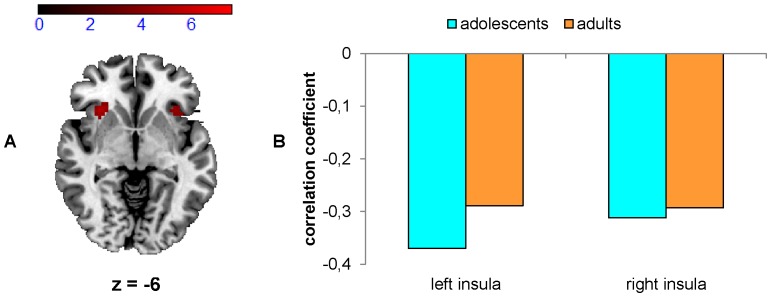
Brain response during error trials.Note that only 181 adolescents and 22 adults who made at least 3 mistakes were considered for this analysis. A) Regions of the brain during error trials that show a significant negative correlation with overall ER (threshold T = 3.84, p<0.05, FDR-corrected, in 25 contiguous voxels) in adolescents. B) Correlation coefficients for the negative correlation between brain response during error trials and overall ER for adolescents (blue) and adults (orange) in the peak voxels (please see also Table S3). The correlation only reached significance in adolescents.